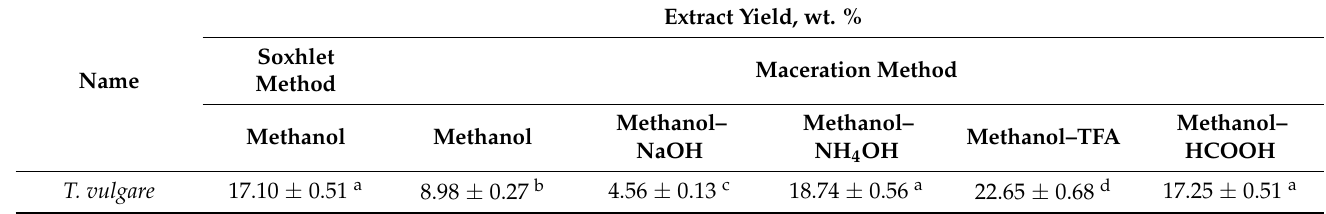
Table 1. Total yield of T. vulgare extracts.